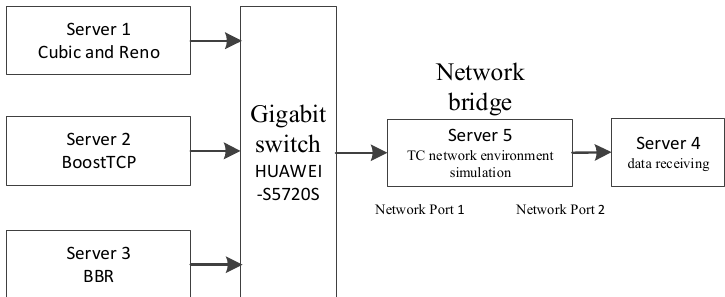
Figure 4. The experimental network structure.